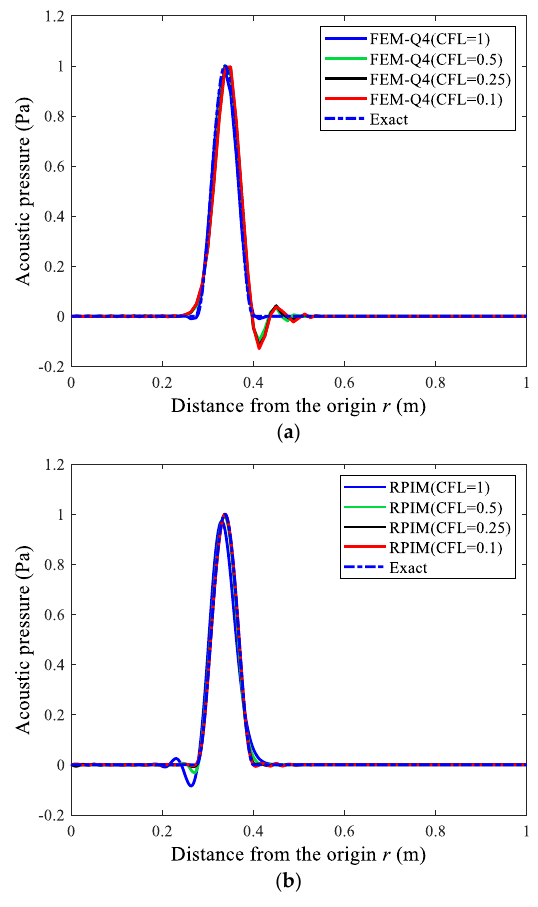
Figure 9. The computed acoustic pressure distribution results from different numerical approaches for the time point t = 0.4 s when the varying non‑dimensional time integration steps are employed: ( a ) FEM‑Q4; ( b )